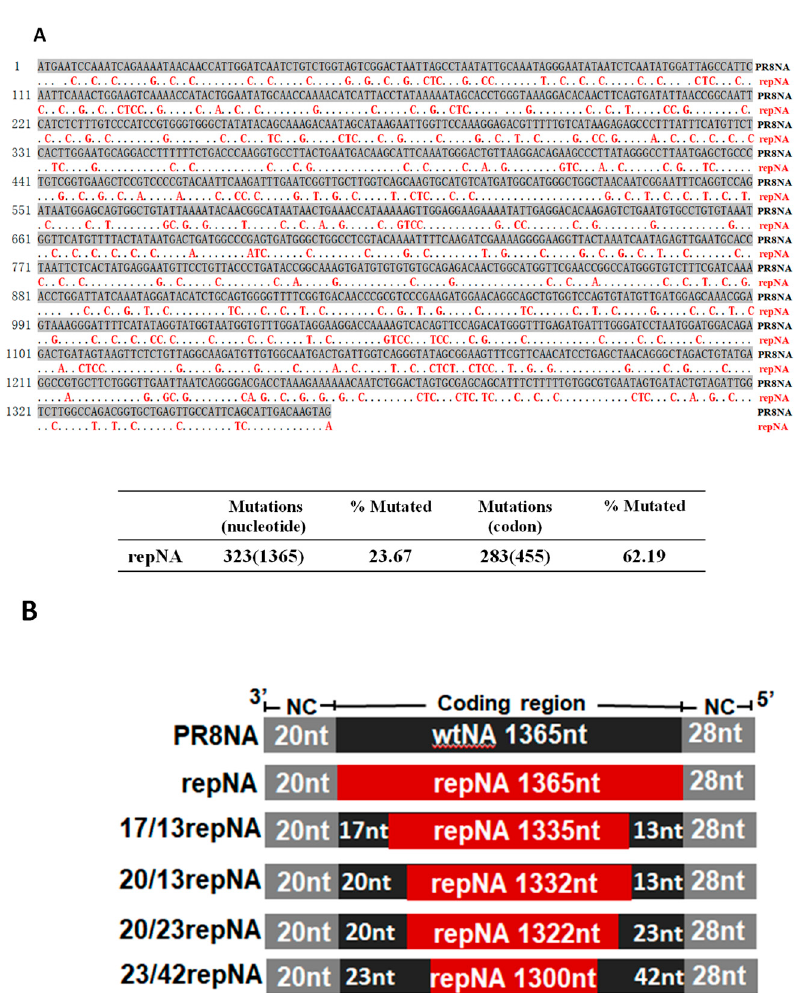
Figure 1. Design of the codon-reprogrammed NA gene. ( A ) Sequence alignment of wild-type and codon reprogramed NA (repNA) genes of PR8 virus (upper panel) and the number and percentage of synonymous nucleotide and codon mutations in the repNA gene (lower panel). The dots in the repNA sequence represent nucleotides identical to those in PR8NA. ( B ) A schematic representation of chimeric wild-type and codon-reprogrammed PR8NA genes. Noncoding regions (NCR) are indicated with gray boxes. The wild-type PR8 NA gene and codon-reprogrammed NA gene are indicated with black boxes and red boxes, respectively.